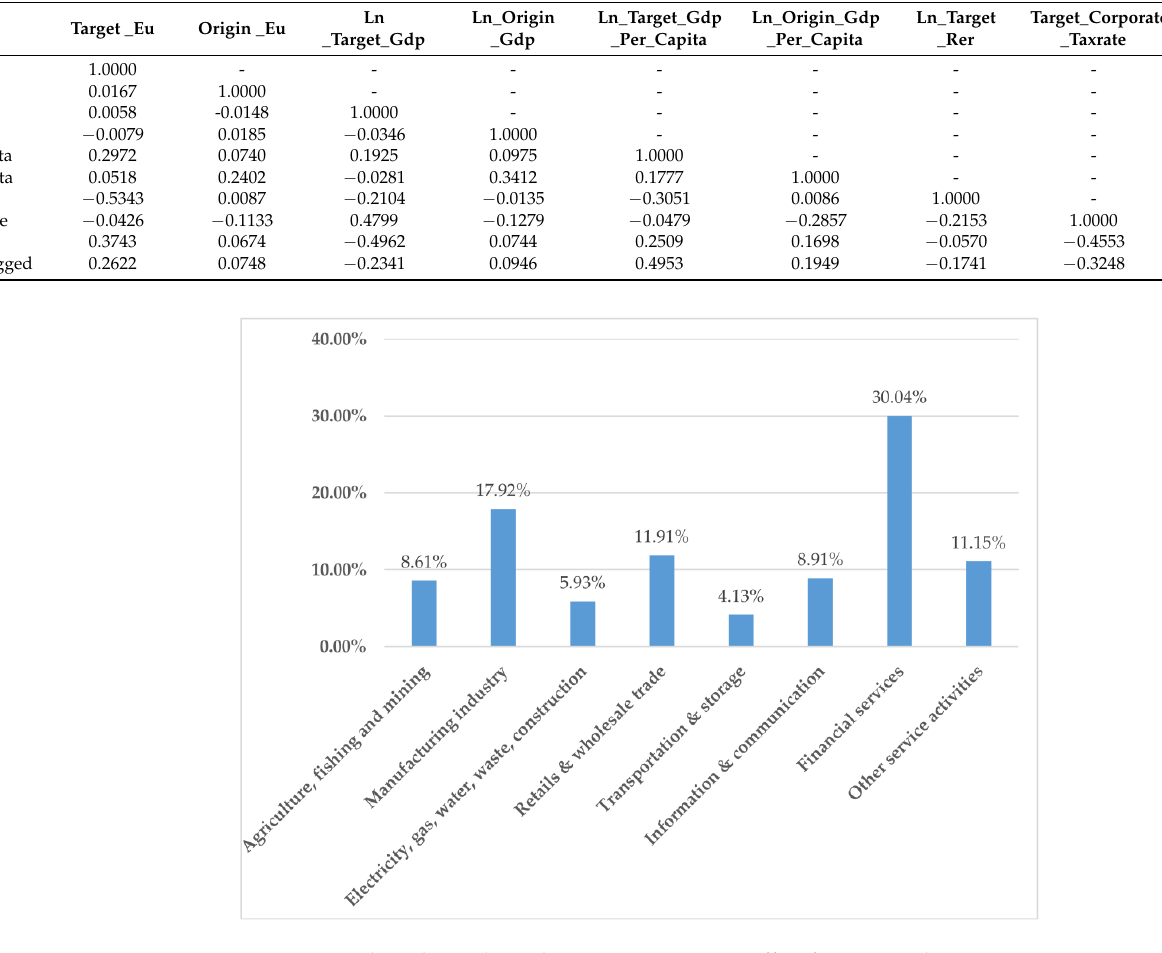
Figure A3. FDI inward stock UK, by industry, 2015. Source: Office for National Statistics, UK 2017.